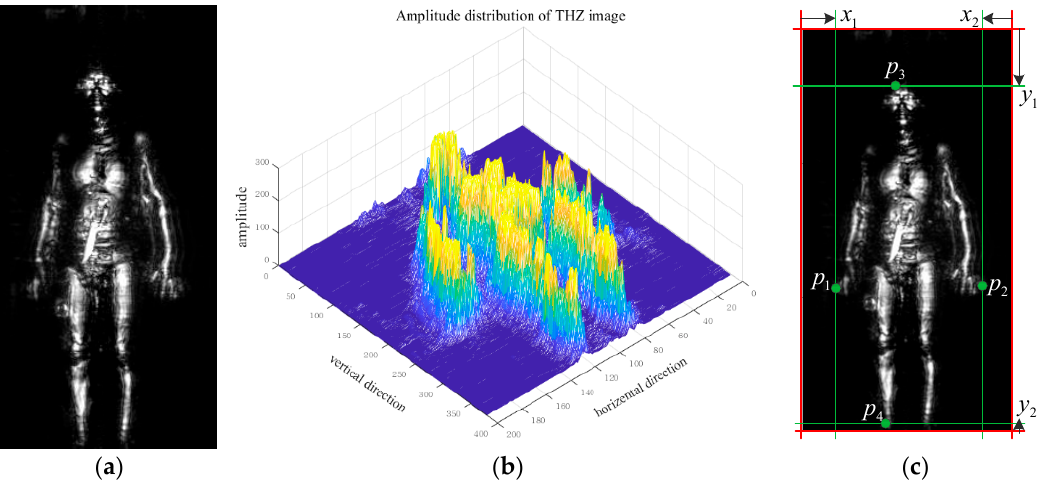
Figure 8. The amplitude distribution of human body in a terahertz image. ( a ) An original terahertz image. ( b ) 3-D amplitude image consistent with Figure 7a. ( c ) Threshold segmentation method based on bounding-slipping.